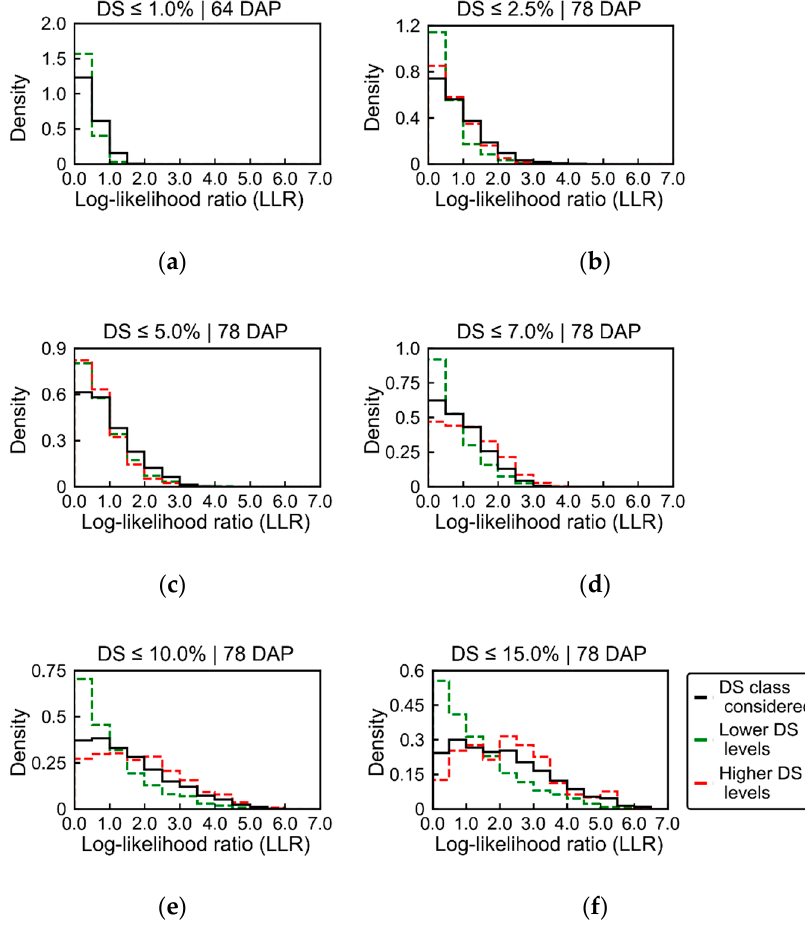
Figure 11. Distribution of log-likelihood ratio (LLR) values derived for patches of UAV images acquired 64 and 78 DAP. Black lines correspond to LLR extracted from sampling units (SUs) within the late blight severity level (disease severity (DS)) considered as hypothesis H1 ( ≤ 1.0%, ≤ 2.5%, ≤ 5.0%, ≤ 7.0%, ≤ 10.0% and ≤ 15.0% of disease severity in a – f , respectively), while comparing with healthier plants (H0, completely healthy for 64 DAP and ≤ 1.0% severity for 78 DAP). Green lines indicate the distribution of LLR values for SUs with lower severity levels than the class considered in each case (e.g., all sampling units with disease severity ≤ 1.0% in b ). Red lines illustrate the distribution of LLR values for SUs with higher severity levels than the class considered in each case (e.g., all sampling units with >2.5% of disease severity in b ).